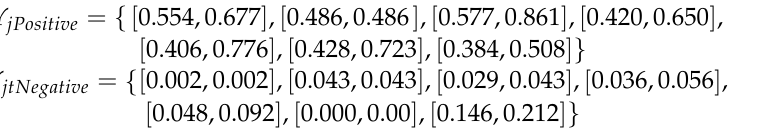
Table A3. The upper and lower bounds of interval parameter values of dimensionless SES ±